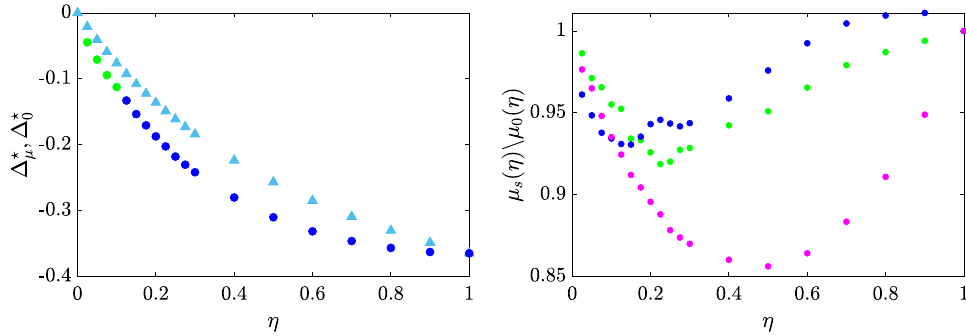
Figure 2. Comparison of the targeted and traditional mass antivax campaigns. The left panel depicts, for each effort η , the additional population fraction � ⋆ µ and � 0 µ that is expected to be vaccinated when the best targeted (identified by circles) or the mass (identified by triangles) antivax campaigns are employed, respectively. The right panel displays for each effort η and targeted strategy s , the ratio between the fractions of the population µ s (η) and µ 0 (η) that are expected to be vaccinated when strategy s and the mass antivax campaign are employed, respectively. In both panels, Strategy 1, 2, and 3 are depicted in blue, green, and magenta, respectively, the intensity of the vaccination campaign is set to α = 1 , and, for the maximum effort η = 1 , all points are superimposed since all strategies would be